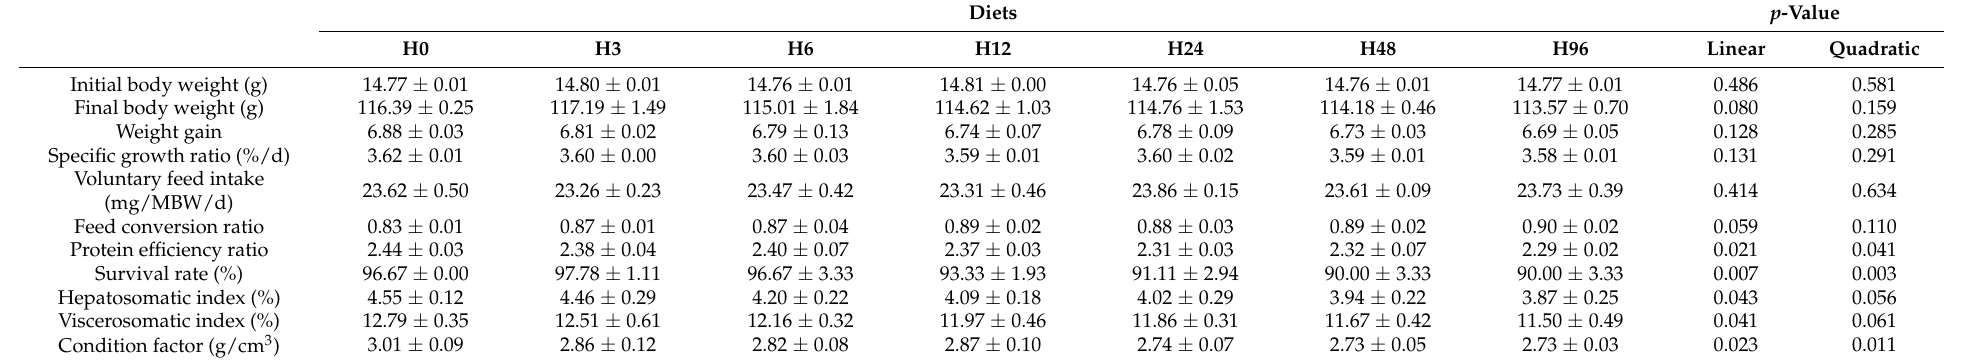
Table 3. Effects of dietary histamine content on growth performance, feed utilization and body index of hybrid grouper.